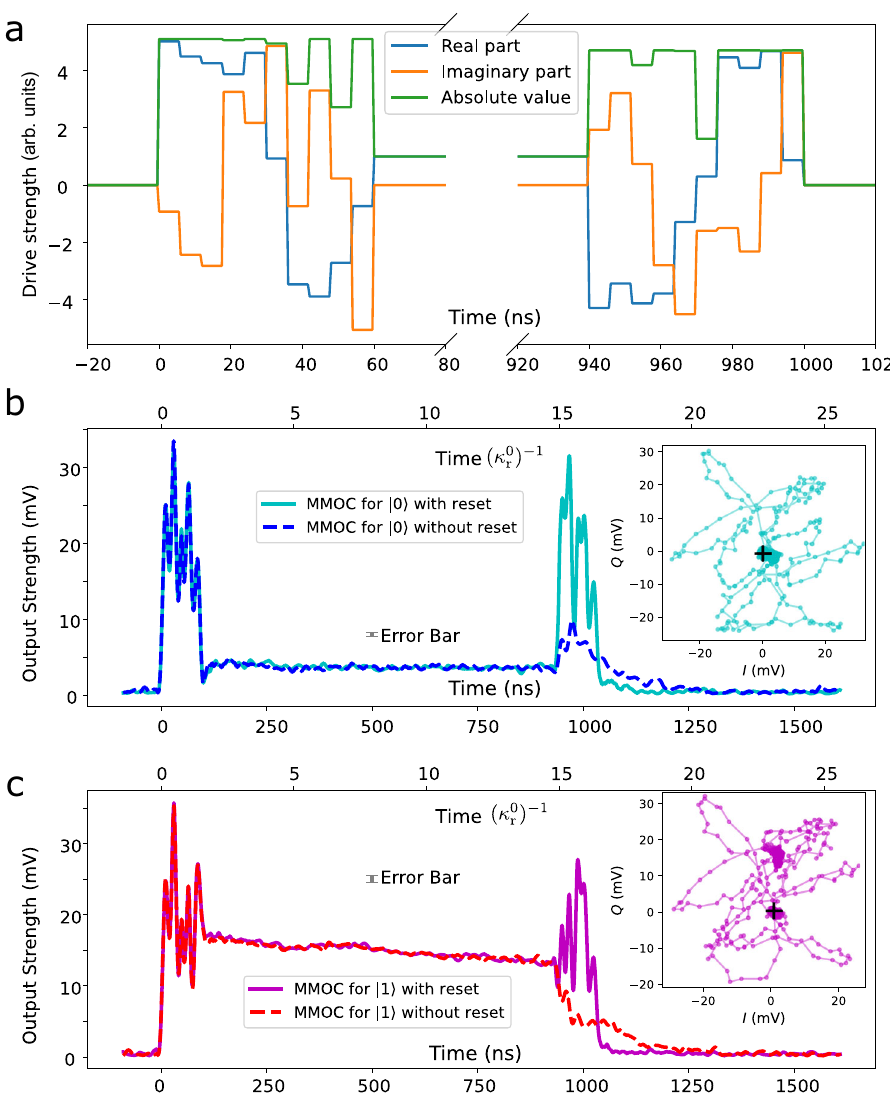
Fig. 3 Multi-mode optimal control (MMOC) by single-port driving. a MMOC pulses. A multi-section pulse with target equilibrium time t f = 60 ns is applied to shortcut thermal equilibrium of both resonator and fi lter modes for different qubit states simultaneously. A different pulse is used to reset to the vacuum state in the end. b , c Measured output amplitudes (in mV) for the MMOC pulses with and without reset. The steady output signal is achieved for qubit state 0 j i ( b ) and 1 j i ( c ) about 30 ns later than the target time, likely due to the high driving amplitude and low-Q energy-storing components in the feedline, such as the impedance-matched Josephson parametric ampli fi er. This explanation is reinforced by the observation of a similar 30 ns tail with a far- detuned and high-amplitude driving which, in principle, will not excite the multi-mode cQED system (Supplementary Note 9). In c , the steady output decays over time due to the T 1 decay of the qubit. The error bar is the standard deviation of the points in the equilibrium states at 930 ns. The good fi nal reset performance for the mixed qubit states demonstrates that MMOC works for both qubit states simultaneously. The corresponding IQ trajectories are plotted inset, from which we can infer the system undergoes highly non-equilibrium dynamics during the MMOC pulse. Trajectories begin at points indicated by black crosses. All data are processed in the same way as in Fig.